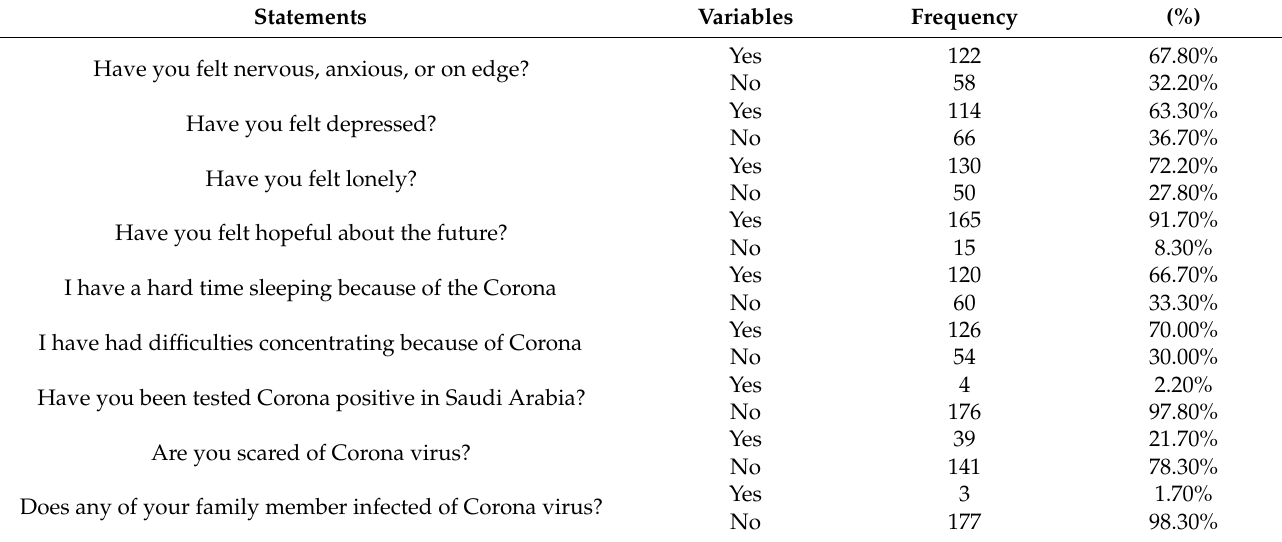
Table 9. Mental health of the migrants during